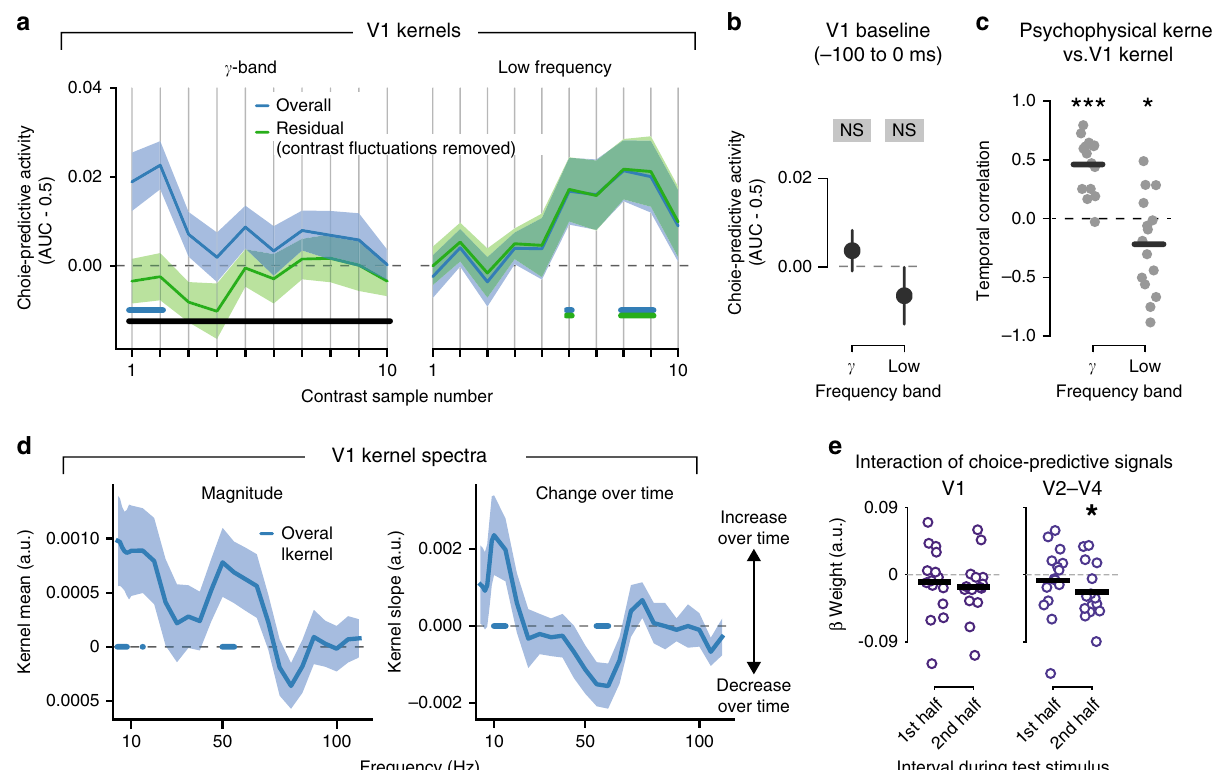
Fig. 4 Dissociating sensory and endogenous components of choice-predictive V1 activity. a Kernels quantifying the impact of hemisphere-averaged V1 power fl uctuations (within each test stimulus category) on behavioral choice (V1 kernels) for V1 activity in the gamma-band (40 – 75 Hz, left) and low- frequency (0 – 20 Hz right). Power values have been extracted at the latency of peak contrast encoding ( t = 190 ms from sample onset). Blue, overall kernels, based on all fl uctuations in V1 power. Green, residual kernels, based on residual fl uctuations after removing effect of external stimulus fl uctuations (see main text). b Test for choice-predictive gamma-band and low-frequency activity during pre-stimulus baseline interval. c Correlation of V1 kernels with psychophysical kernel from Fig. 1B. Each dot is one participant. Black lines, group average. γ , t (14) = 6.5, p = 1.3 × 10 − 5 ; low, t (14) = − 2.19, p = 0.045, n = 15 subjects. d Frequency spectra of choice-predictive activity in V1. Left, kernels collapsed across time. Right, change of kernels across test stimulus interval (slope across samples). e Interaction of impact of low-frequency and gamma-band activity on behavioral choice, for areas V1 and V2 – V4. V2 – V4, 2nd half: t (14) = − 2.4, p = 0.0305. Data in a , d are represented as mean ( n = 15 subjects, lines) and ±SEM (shaded areas); in b are mean ( n = 15 subjects, dots) and ±SEM (error bars); in c , e , as mean ( n = 15 subjects, horizontal lines) and individual subjects (dots). All p -values from two-sided t -tests. Horizontal bars in a , d : p < 0.05 (colored bars, difference from 0; black bars, difference between blue and green). Asterisk * p < 0.05; *** p < 0.001; Source data are provided as a Source Data fi